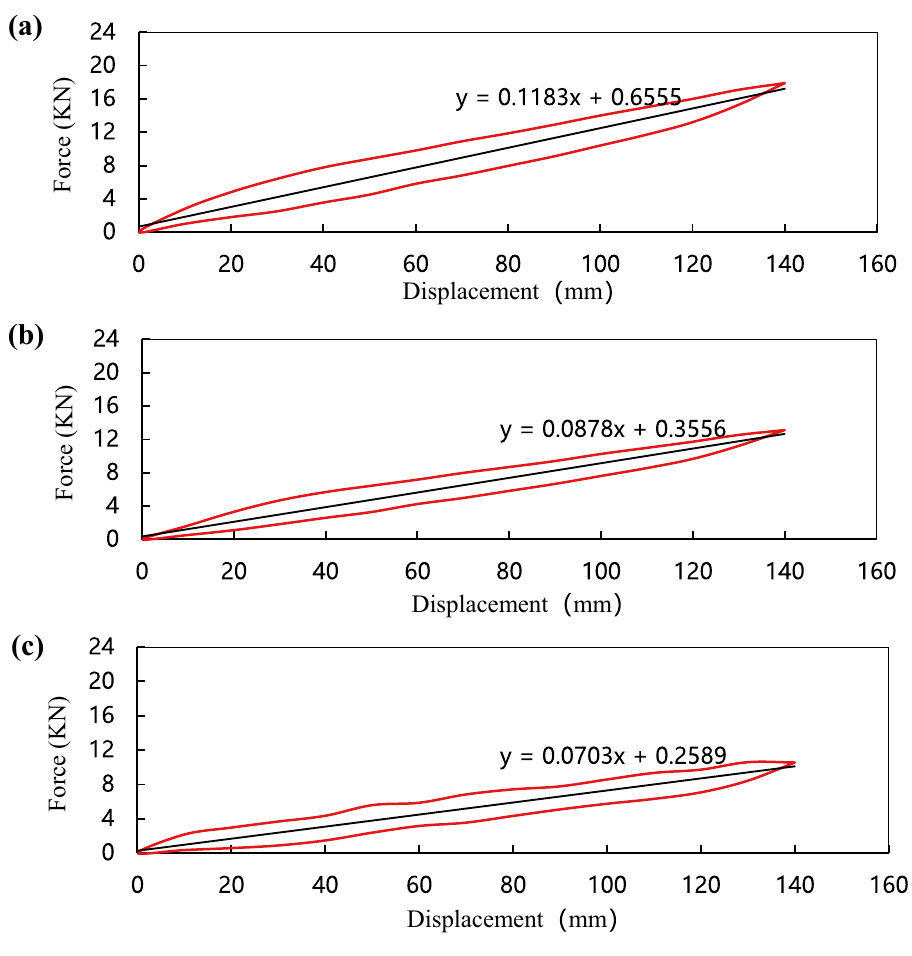
Figure 4. Stiffness curves of leaf springs with different laying angles; ( a ) Specimens 1 test data; ( b ) Specimen 2 test data; ( c ) Specimen 3 test data.